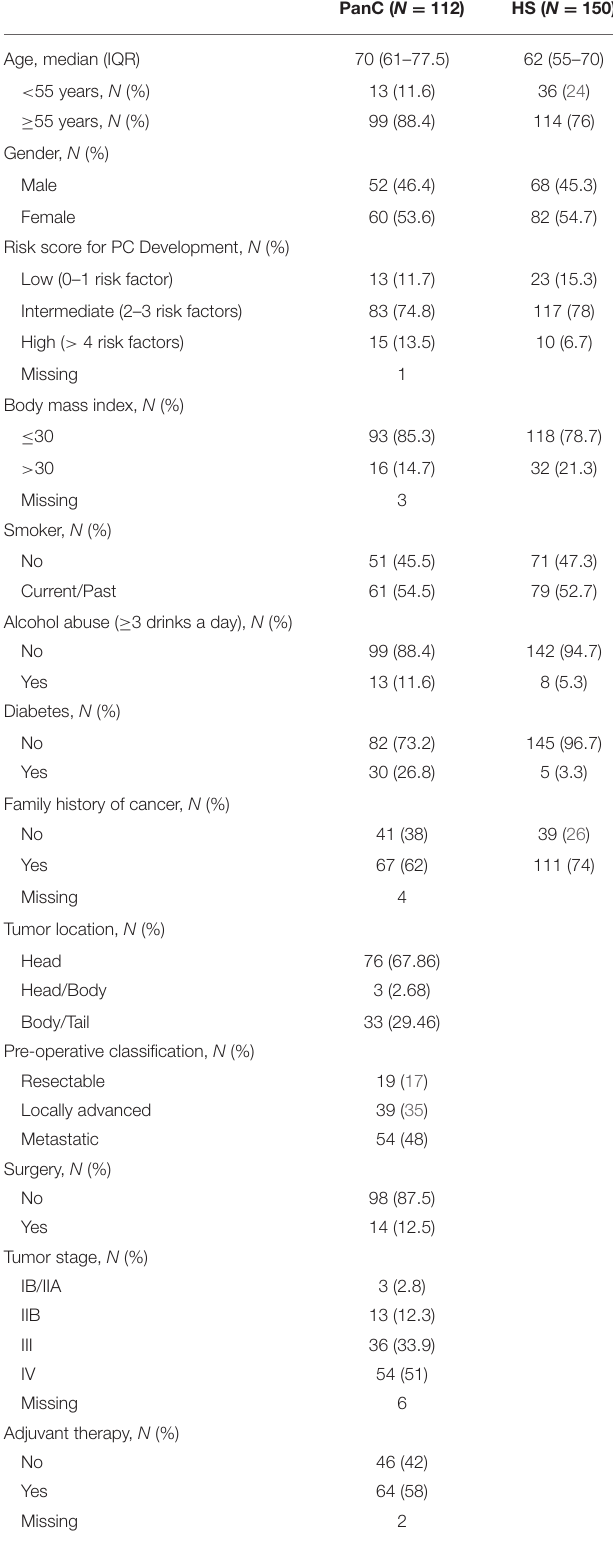
TABLE 1 | Demographics characteristics, clinical risk factors in healthy subjects (HS) and patients with pancreatic cancer (PanC), and baseline clinical-pathological features of PanC patients included in the validation